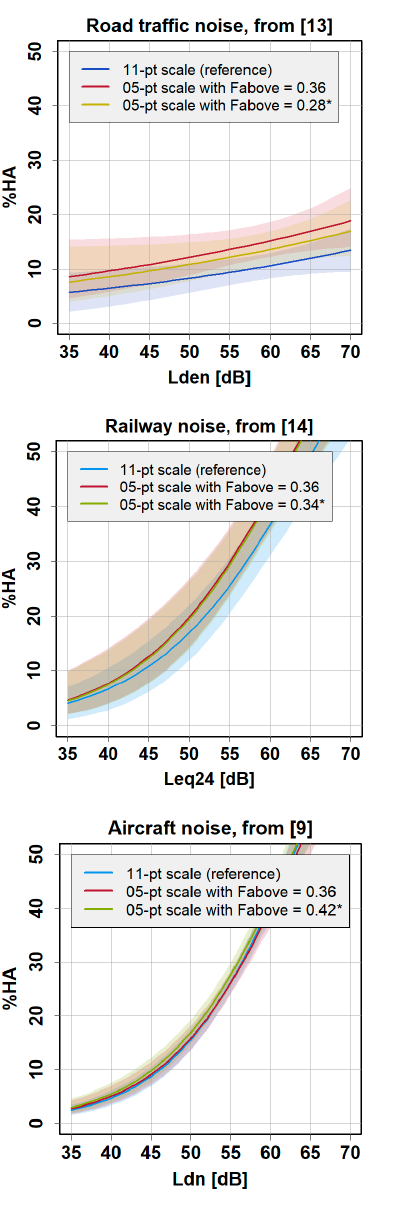
Figure 5. Exposure–response curves from different noise annoyance surveys showing %HA, as derived from the 11-point scale with cutoff point at 72.73% (“reference”), as well as based on the simulation with responses from the 5-point scale (with 95% confidence intervals as shaded areas). Two simulated curves are shown, one for F above = 0.36 and one for the empirically derived F above value of the respective study, marked with an asterisk (*). Curves are based on a simple unadjusted (crude) model. Data sources are from the following studies: [7–9,12–15] .